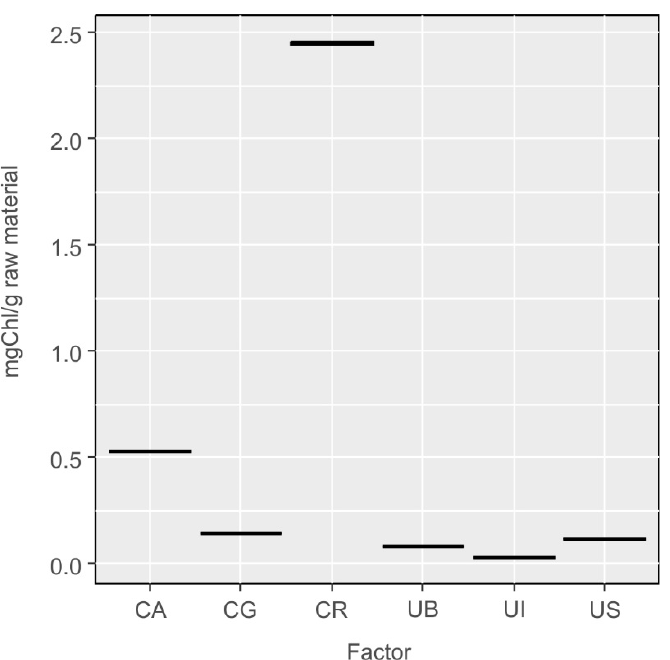
Figure 5. Results of determinations of the total content of chlorophyll in the extracts from Ulva and Cladophora species, converted into milligram of chlorophyll per gram of raw material.